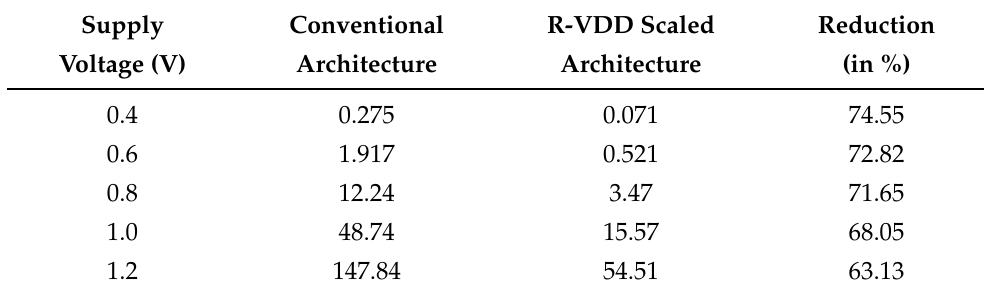
Table 3. Hold power (nW) of memory architecture with various supply